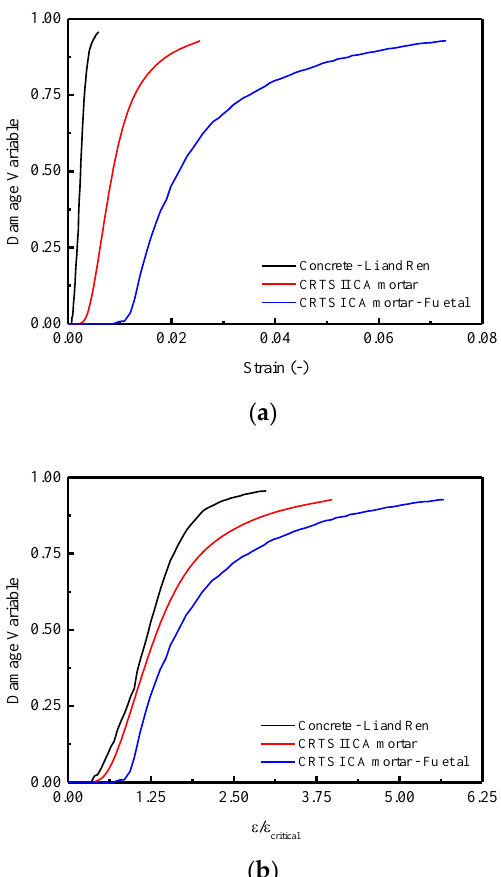
Figure 17. Comparisons of the mean constitutive relationships among CRTS II CA mortar, CRTS I CA mortar, and concrete under compression in terms of: ( a ) 𝑑 - 𝜀 curve; ( b ) 𝑑 - 𝜀 / 𝜀 𝑐𝑟𝑖𝑡𝑖𝑐𝑎𝑙 curve.